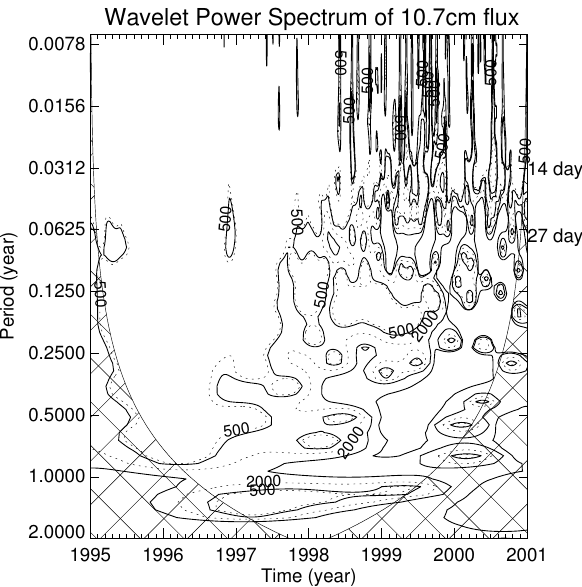
Fig. 12. Wavelet spectra of ion temperature during the nighttime. Other details same as in Fig. 1.